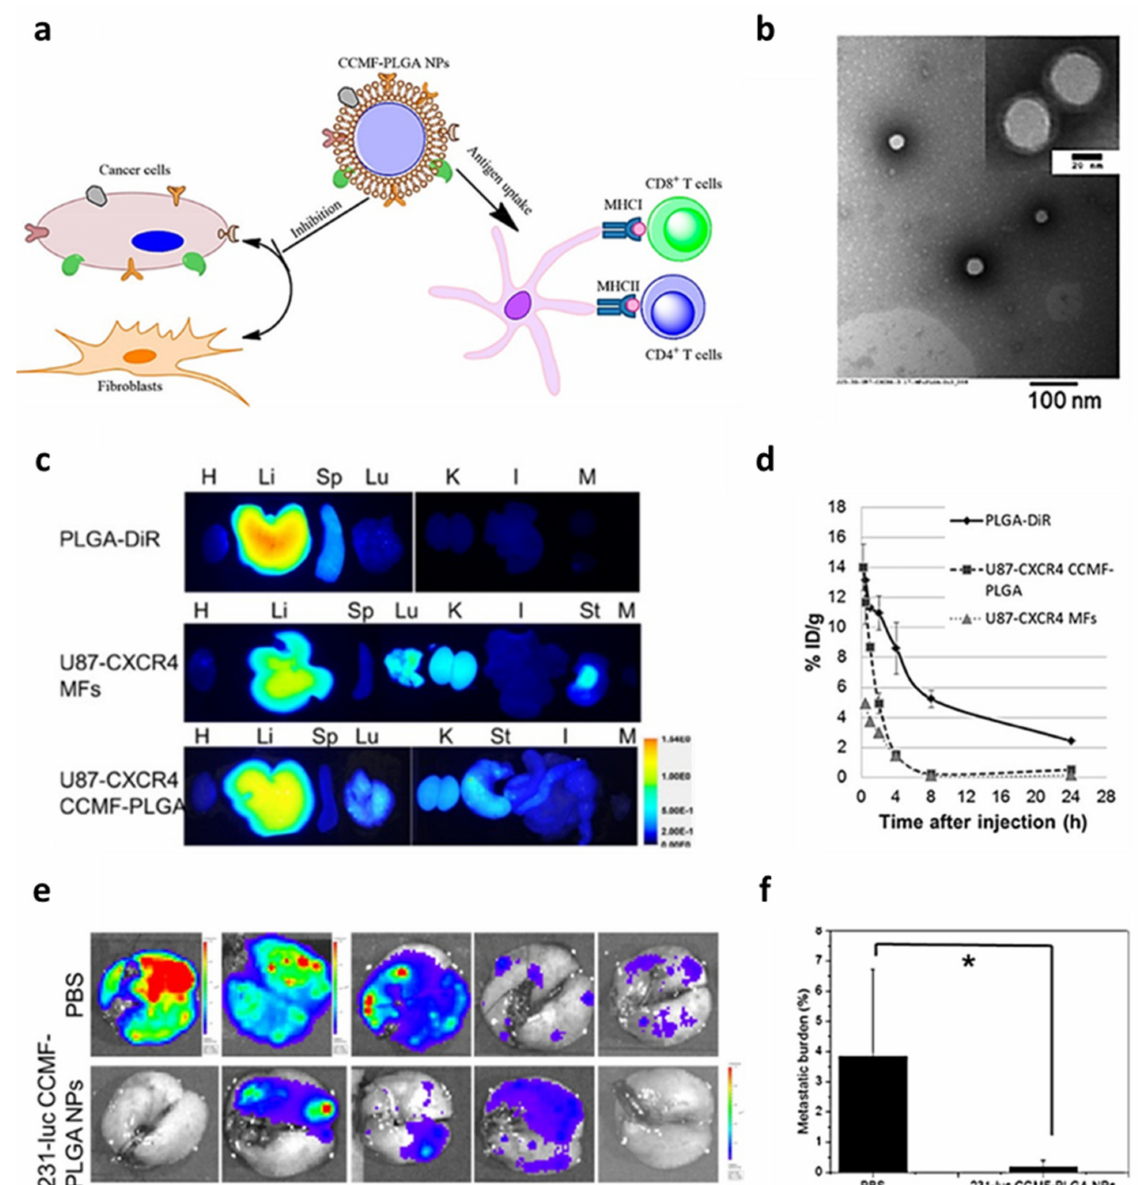
Figure 7. ( a ) Schematic illustration of the use of cancer cells membrane fraction-coated PLGA nanoparticles (CCMF-PLGA-NPs) to inhibit fibroblasts-cancer cells interactions and induce antitumor immunity via antigen presenting cells. ( b ) Representative TEM images of U87 cells-derived CCMF- PLGA-NPs (U87-CXCR4 CCMF-PLGA NPs) with insets showing high-magnification images.